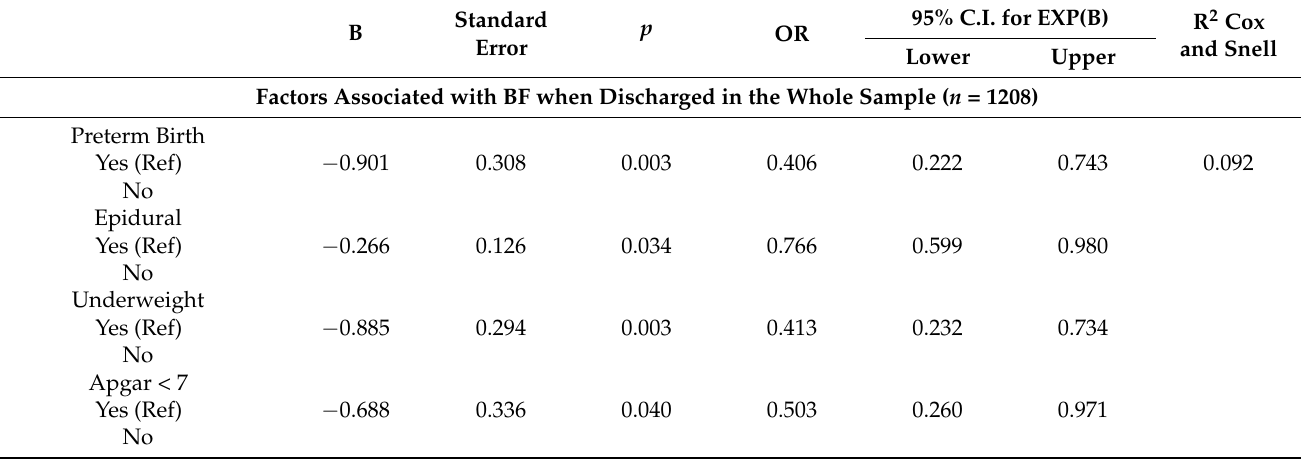
Table 3. Factors associated with BF when